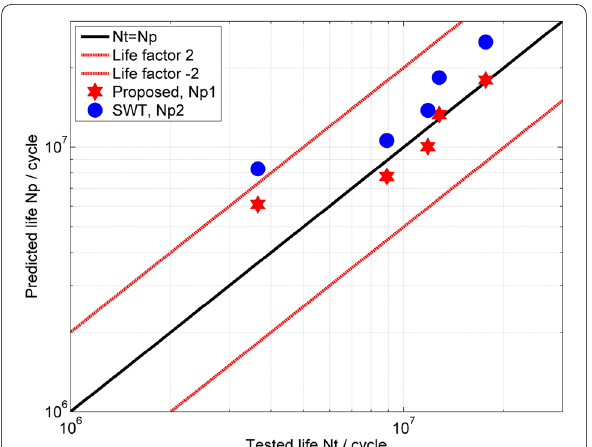
Figure 12 Prediction error of GH4133